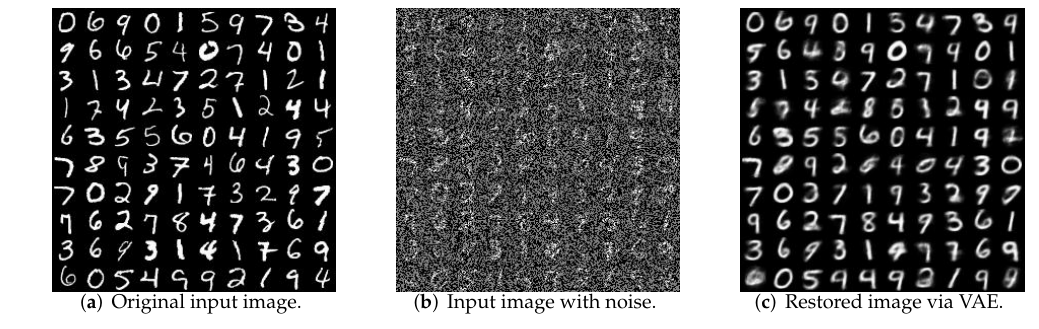
Figure 9. Reconstruction quality for noise